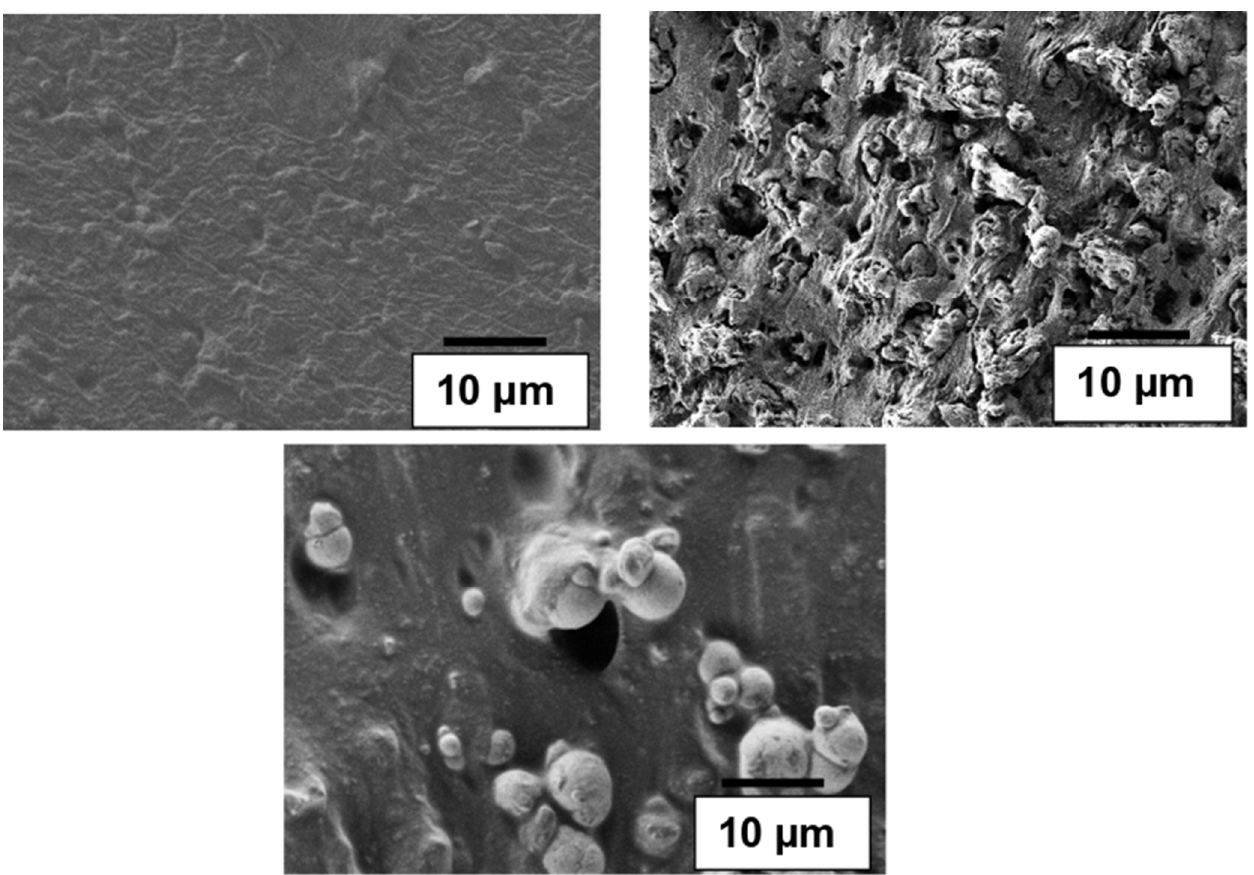
Figure 5. Regular carbonyl iron particle within elastomer matrix: ( top right ) elastomer polymer; ( top left ) Particles within the polymer; ( down ) zoom view of the adhesion of the particles within polymer.